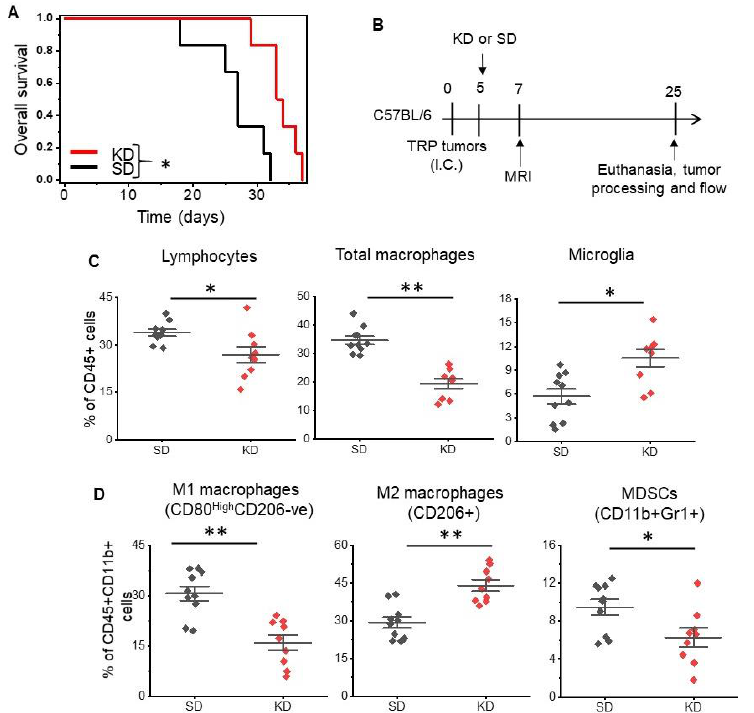
Figure 1. The ketogenic diet modulates macrophage polarization in GBM. Mouse-derived genet- ically engineered GBM cells (TRP) were grown orthotopically in immune-competent C57BL/6 mice fed a standard rodent diet (SD) rodent diet or a ketogenic diet (KD) ad libitum. ( A ) Sur- vival analysis between KD and SD. n = 6/group. ( B ) The schema used for correlative stud- ies. ( C ) Tumors harvested from KD and SD fed mice were immunophenotyped, evaluating for total lymphocytes (CD45+CD11b-ve), total macrophages (CD45+CD11b+), and microglial cells (CD45 medium CD11b+), ( D ) M1 macrophages (CD45+F4/80+CD11b+CD80 High CD206-ve), M2 macrophages (CD45+CD11b+F4/80+CD206+CD80 Low ), and myeloid-derived suppresser cells (MD- SCs) (CD45+CD11b+Gr1). The line between the data points represents the mean, and the whisker represents SE. n = 9–10/group. *: p < 0.05, **: p <